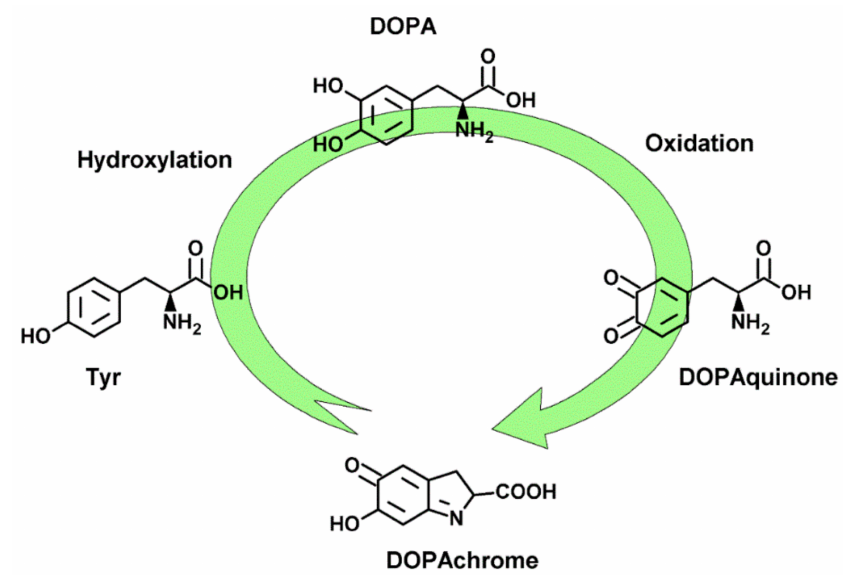
Scheme 2. Products of tyrosine hydroxylation and oxidation by tyrosinase.